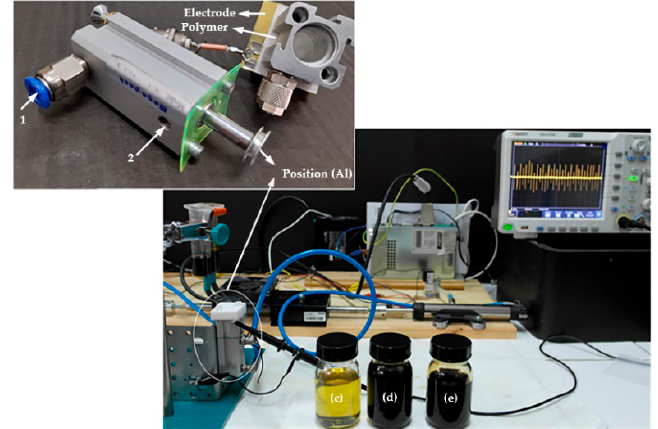
Figure 29. A pneumatically driven online triboelectric oil oxidation sensor (Reprinted with permission from Ref. [212]. Copyright 2022 Elsevier).